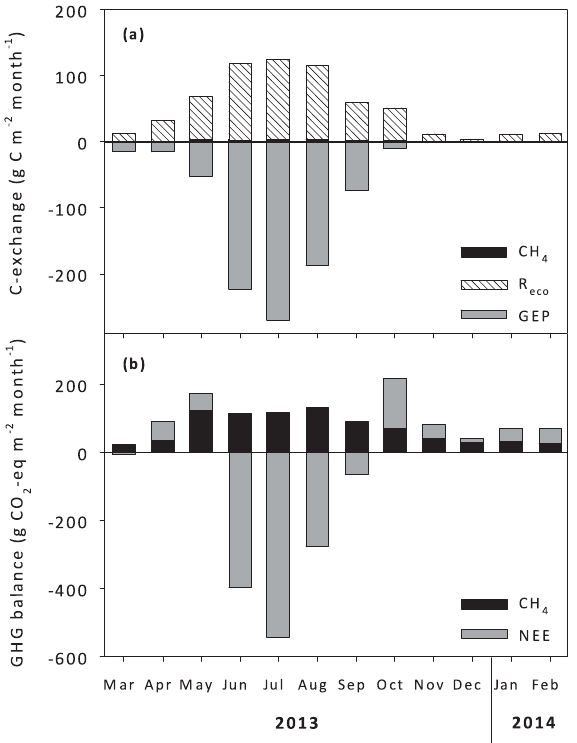
Figure 8. (a) Monthly accumulated carbon fluxes from CH 4 and CO 2 divided between ecosystem respiration ( R eco ) and gross ecosystem production (GEP). (b) Carbon fluxes in CO 2 equivalence from CO 2 (net ecosystem exchange, NEE) and CH 4 , where CH 4 fluxes are multiplied by a global warming potential (GWP 100 ) of factor 28 (IPCC,